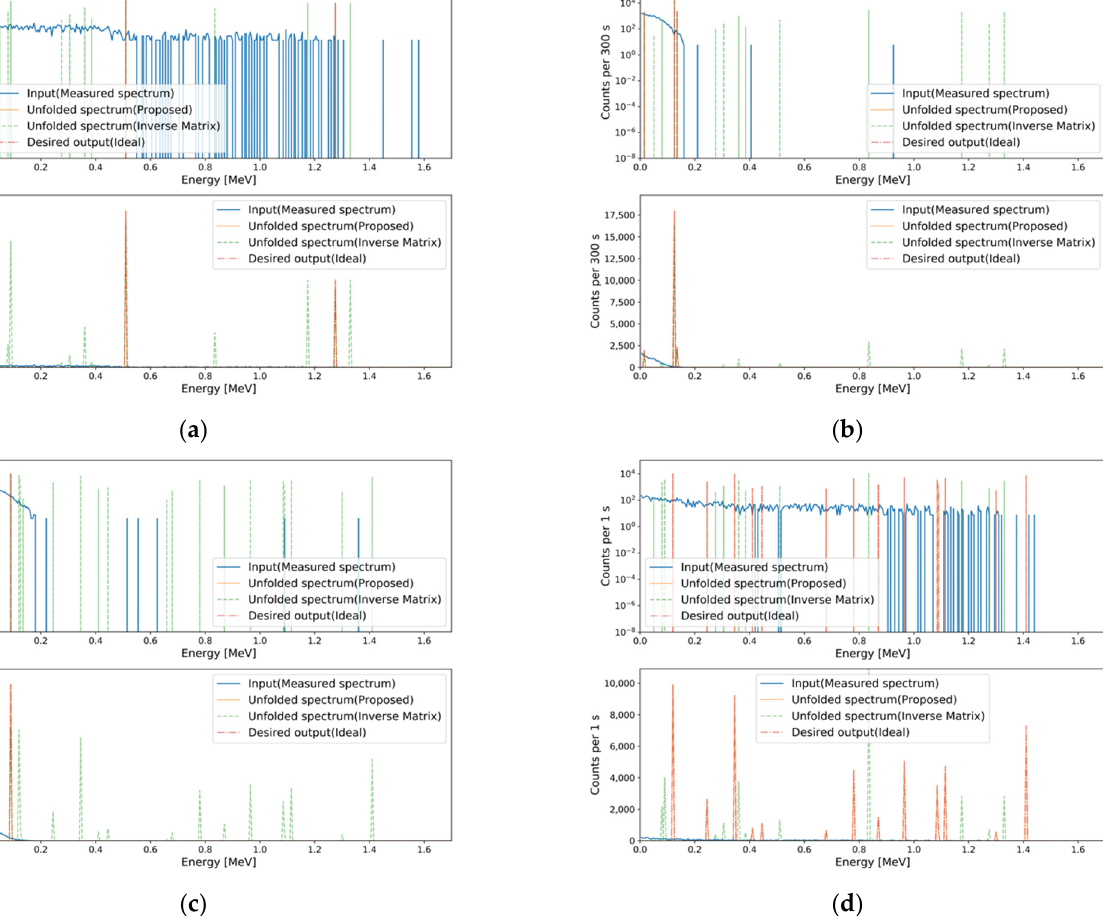
Figure 12. Unfolding results using the inverse of the transfer matrix and the final MTL model for measured spectra whose total net counts are the evaluated MRCs for the generation task. Results of ( a ) 22 Na; ( b ) 57 Co; ( c ) 109 Cd; ( d ) 152 Eu. The MAPEs of the inverse of the transfer matrix and the final MTL model, respectively, are ( a ) 1.152 × 10 3 and 3.999 × 10 − 1 ; ( b ) 2.492 × 10 2 and 5.999 × 10 − 1 ; ( c ) 1.483 × 10 3 and 1.999 × 10 − 1 ; ( d ) 7.709 × 10 2 and 2.799 × 10 − 1 .